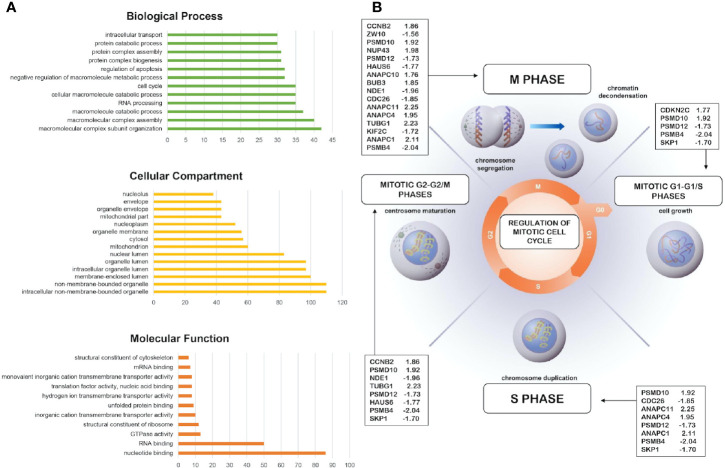

Bioinformatics analysis of the differentially expressed genes and pathway analysis.
(A) More representative Gene Ontology enrichment of differentially expressed genes (DEGs) in cellular component, molecular function, and biological process. Count: number of genes related to the enriched GO. (B) Overrepresentation and enrichment analysis of DEGs in cell cycle, mitotic phase (R-HSA-69278). The fold change value of indicated genes are reported.